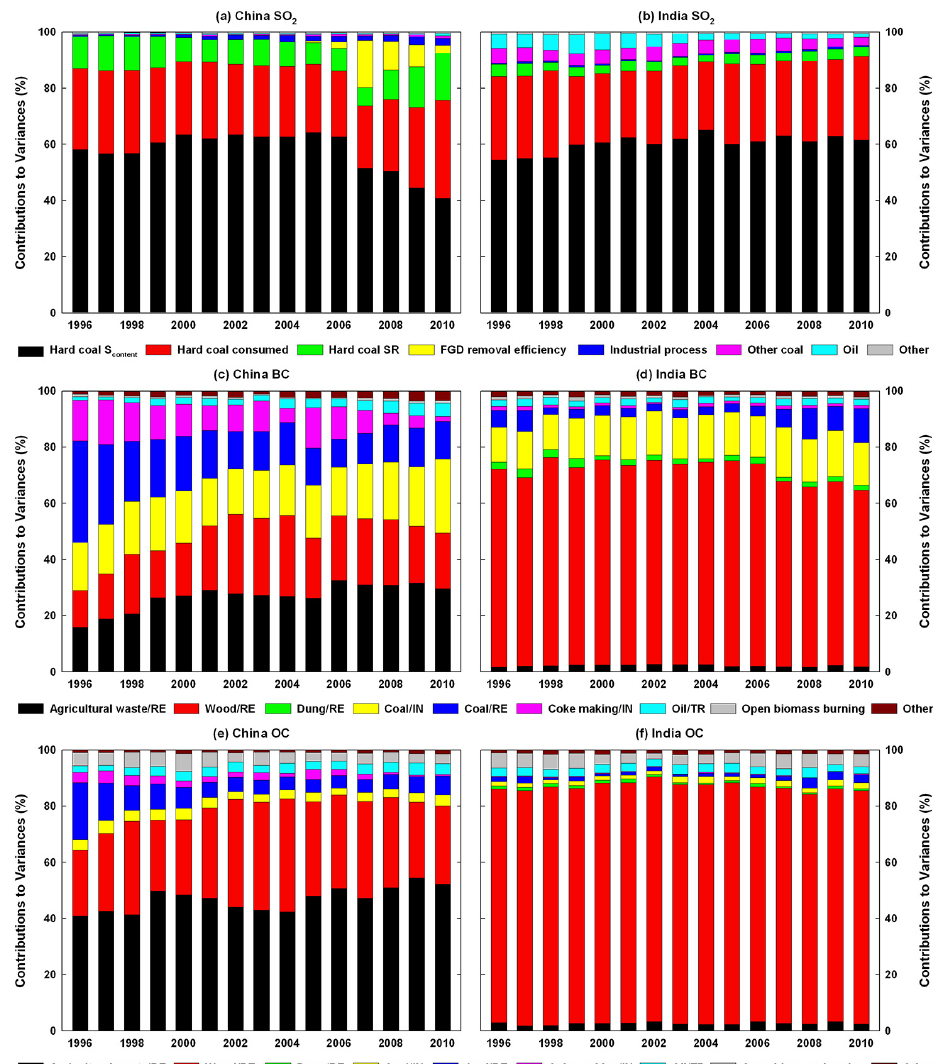
Fig. 7. The contributions of major parameters or fuel/usage combinations to variance in SO 2 (a, b) , BC (c, d) , and OC (e, f) emissions from China (a, c, e) and India (b, d, f) during 1996–2010. IN, RE, and TR represent industry, residential, and transportation sector, respectively.